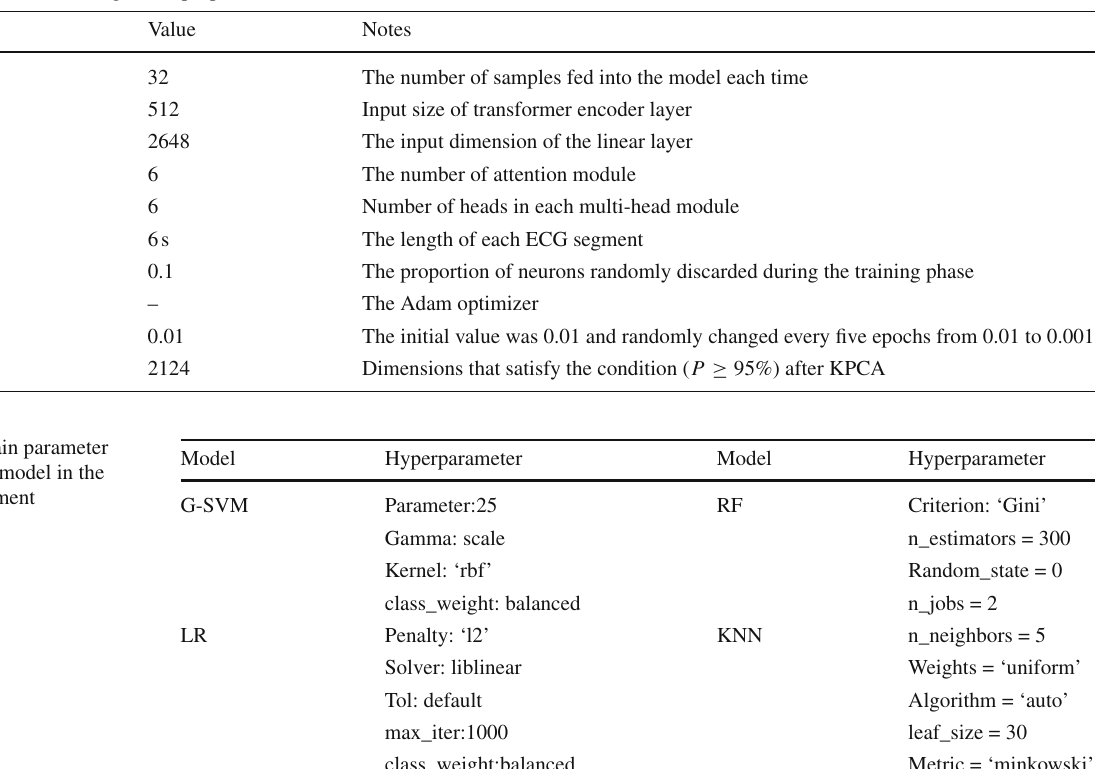
Table 2 The parameter setting of the proposed DI-Transformer model Parameters